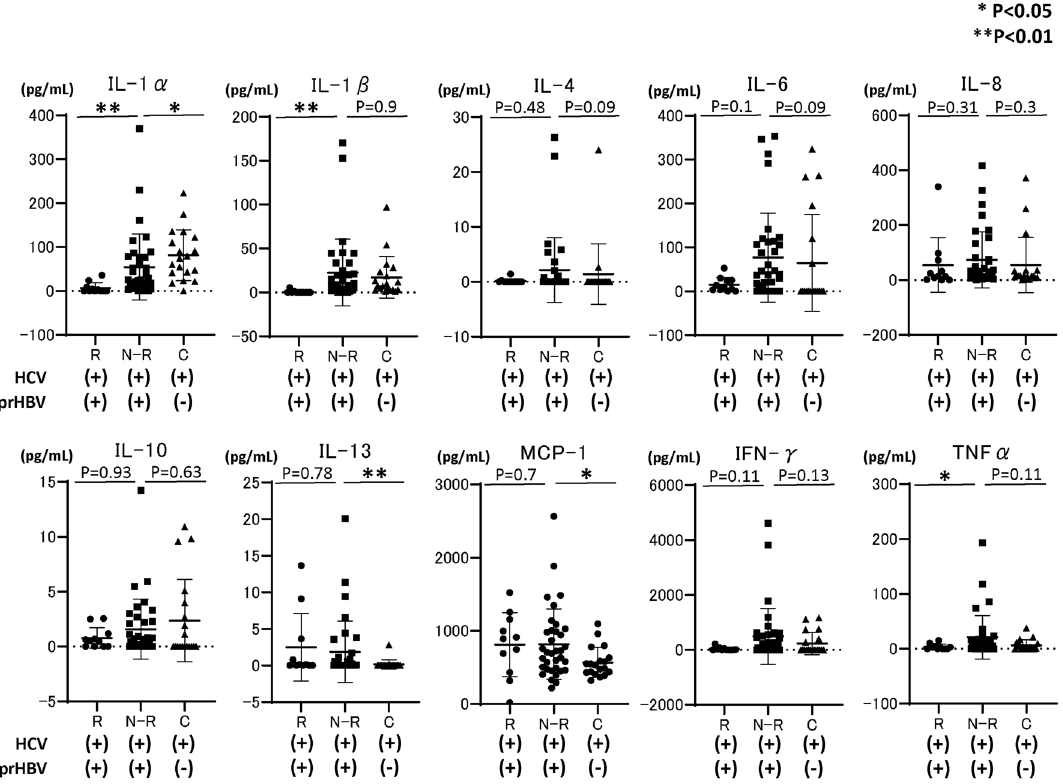
Figure 1. Comparison of baseline cytokine levels among HCV-infected patients with previous HBV infection, those with or without HBV reactivation during DAA therapy, and HCV-infected patients without previous HBV infection. Each data are shown as median ± SD. *P < 0.05, ** P < 0.01. HCV hepatitis C virus, HBV hepatitis B virus, DAA direct-acting antiviral, IL interleukin, MCP monocyte chemotactic protein, IFN interferon,